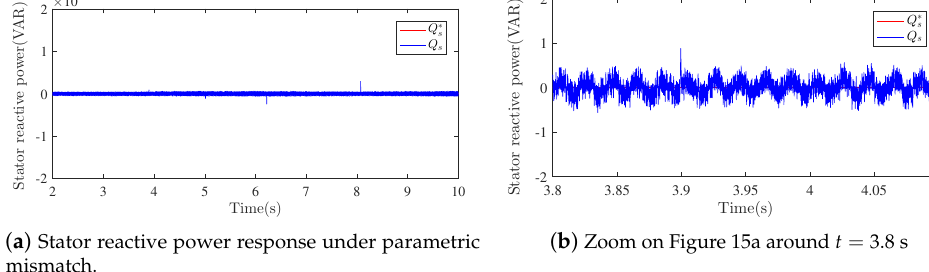
( a ) Stator reactive power response under parametric mismatch.